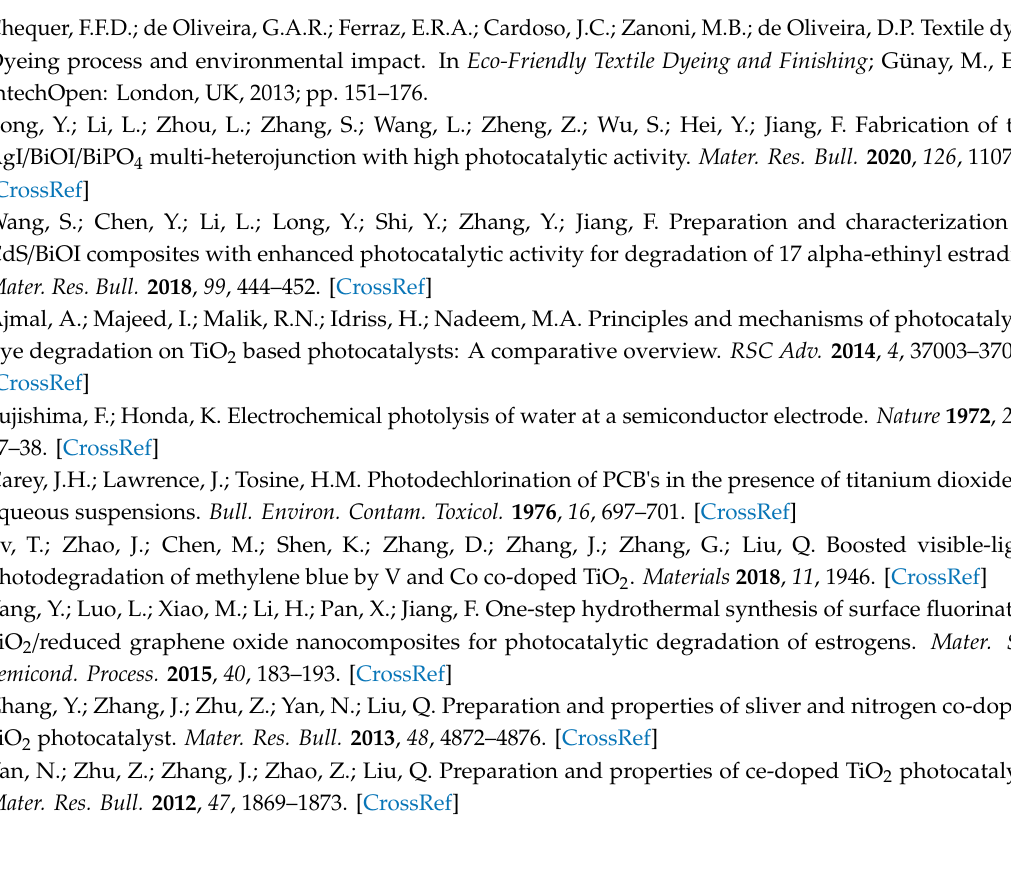
Figure S1: Spectrum of high power Mercury-Xenon Hg (Xe) lamps used in this study. Figure S2: Schematic illustration of C-dots synthesis. Figure S3: Fluorescence emission spectra of C-dots excited at di ff erent wavelengths; and relative fluorescence intensity of C-dots exposed to ambient light with di ff erent time durations. Figure S4: Cell viability test of C-dots using MTS assay. Figure S5: The photo-degradation of RhB and MB without the presence of photocatalysts. Figure S6: The photocatalytic degradation of MB catalyzed by C-dots (0.75 mg / mL) by monitoring the absorption at 664 nm. Table S1: Table showing the XPS elemental atom % and BEs of O 1s, N 1s and C 1s core